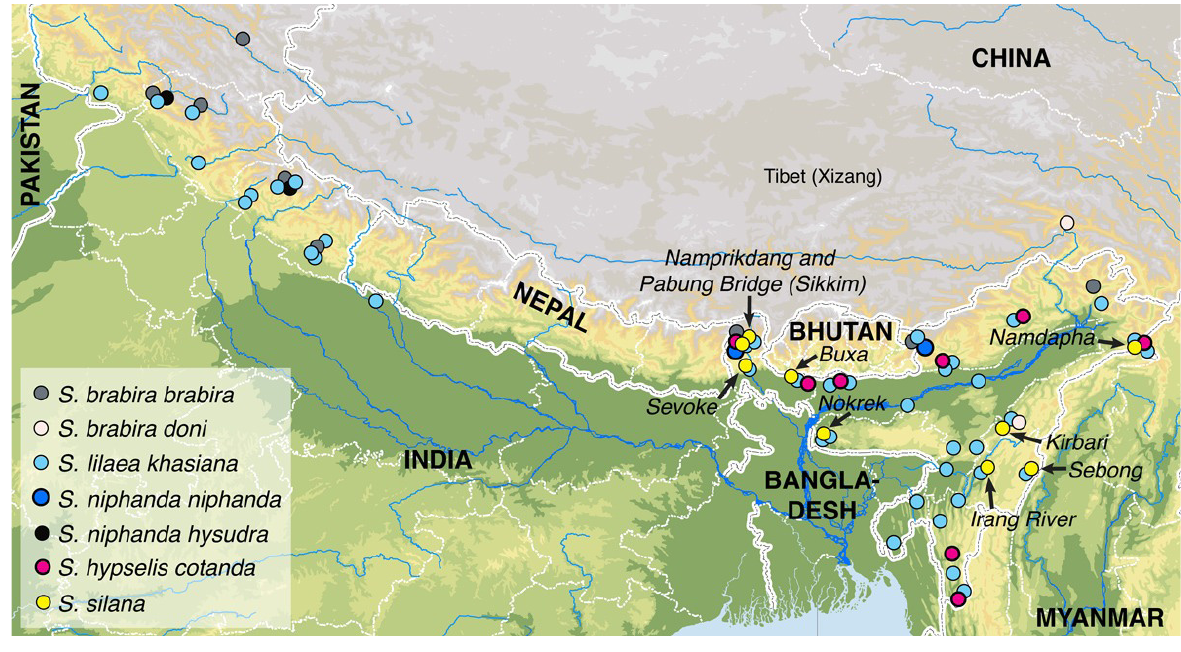
Image 2. Distribution of Indian Symbrenthia . Each spot on the map, color-coded with subspecies name, represents a single spot record. Data are from old literature (de Nicéville 1885, 1886; Moore 1899-1900; Tytler 1915) and unpublished